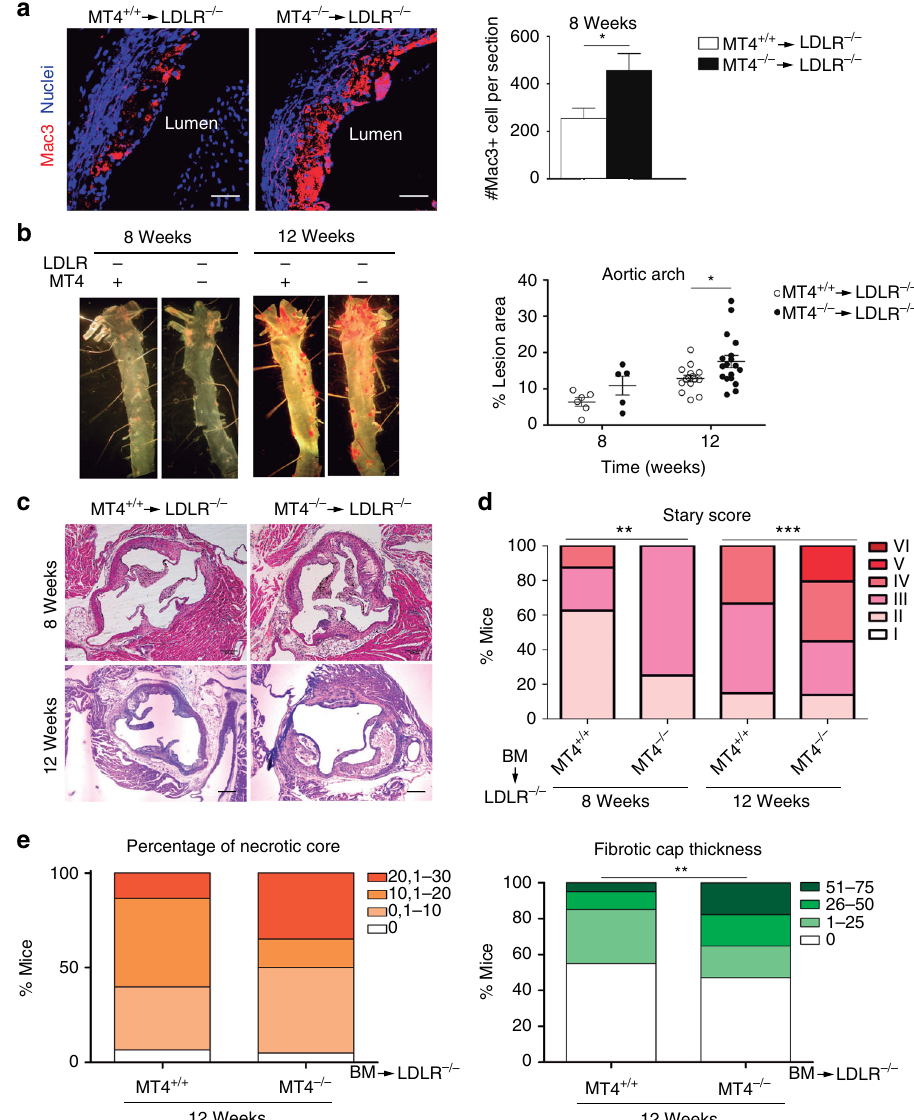
Fig. 2 Lack of MT4-MMP in BM-derived cells results in increased macrophage burden in atherosclerotic plaques and accelerated AT. a Representative images of Mac3 immunostaining (red; nuclei in blue) in transverse sections of aortas from Ldlr – / – mice transplanted with MT4-MMP + / + (MT4 + / + ) or MT4-MMP – / – (MT4 – / – ) BM cells and fed a HFD for 8 weeks; scale bar, 20 µ m. The right panel shows Mac3-positive cells quanti fi ed by Image J. n = 6 mice per genotype in two independent experiments. b Representative images of en face Oil Red-stained aortas from BM-transplanted Ldlr – / – and fed a HFD for 8 or 12 weeks (left) and graph shows the area (%) of Oil Red-positive lesions in the aortic arch (right); n = 6 and n = 16 mice per genotype for 8 and 12 weeks in two and three independent experiments, respectively. c Representative images of transverse sections of aortic sinus stained with H&E of BM- transplanted Ldlr – / – mice; scale bar, 200 µ m. d Stary scoring (I – VI) of aortic lesions of BM-transplanted Ldlr – / – mice, shown as a percentage of all mice for each condition after feeding a HFD for 8 or 12 weeks; n = 6 and n = 16 mice per genotype and time point in two and three independent experiments. e Bar graphs show the percentage of BM-transplanted Ldlr – / – mice for each range of % of necrotic area (left) and fi brotic cap thickness (right) after 12 weeks of HFD; n = 16 mice per genotype in three independent experiments. Data were tested by two-tailed Student ’ s t -test in a , by two-way ANOVA followed